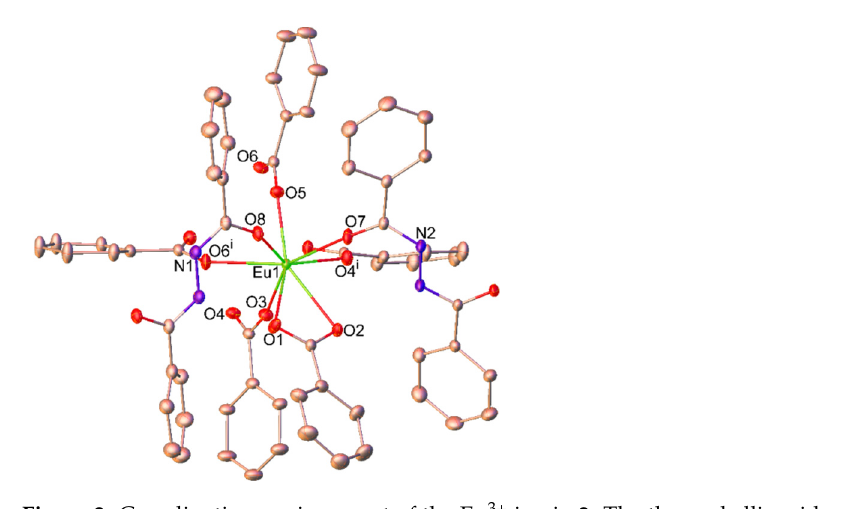
Figure 2. Coordination environment of the Eu 3+ ion in 2 . The thermal ellipsoids are drawn at the 30% probability level for non-hydrogen atoms. Hydrogen atoms attached on the carbon and nitrogen atoms are omitted for clarity. Symmetry code: (i) 3/2 − x , 1 − y , z .